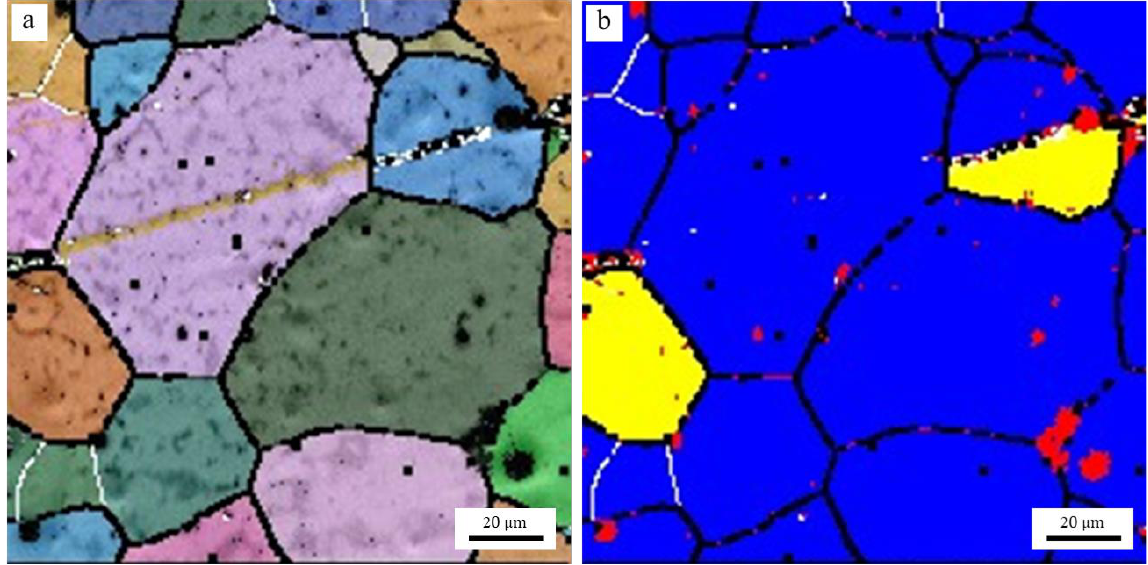
Figure 14. ( a ) IPF and ( b ) substructure distribution maps of AZ91 annealed at 400 °C for 72 h. White lines correspond to low- angle grain boundaries with misorientations of 2° < θ < 15° and black lines correspond to high- angle grain boundaries with misorientations θ > 15°. In ( b ), yellow, blue, and red represent the substructure, recrystallization, and deformation, respectively.